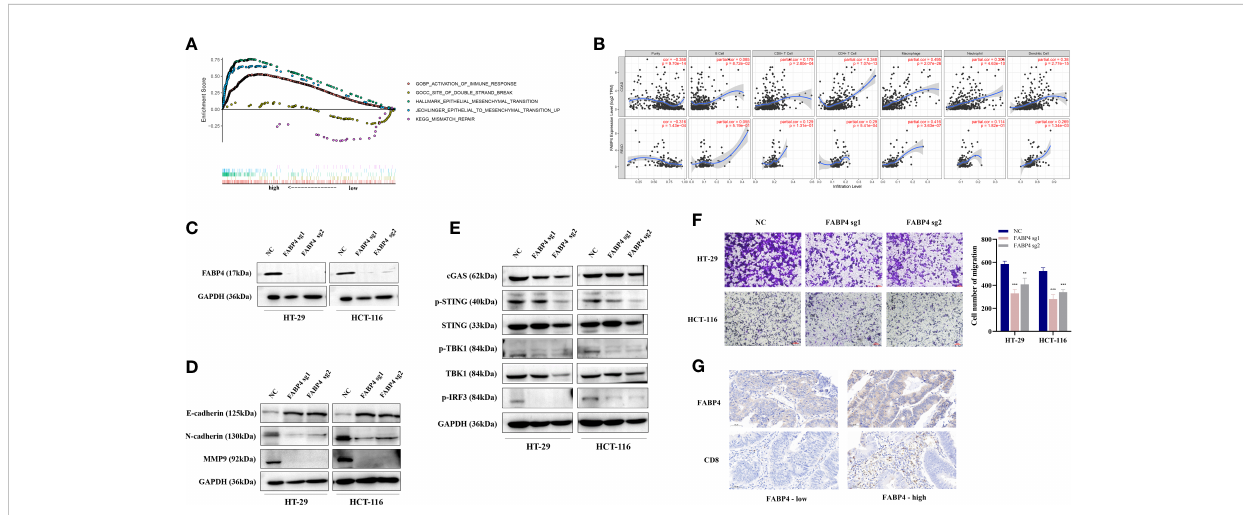
FIGURE 7 The biological function of FABP4 in CRC immunity and metastasis. (A) The TCGA-CRC dataset was divided into FABP4 high- and low-expression group based on FABP4 expression. GSEA analysis showed that the differentially expressed genes were signi fi cantly associated with immunity, EMT, and DNA damage repair pathways; (B) TIMER analysis showed a signi fi cant positive correlation between FABP4 and CD8 + T cells, CD4 + T cells, and neutrophils in CRC; (C) Western blot validated the knockout ef fi ciency of FABP4 in HT-29 and HCT-116 cells; (D) Western blot probed the expression of EMT-related proteins in FABP4 -KO cells; (E) Western blot showed the expression of DNA damage-repair-related pathway (cGAS-STING)-associated genes in FABP4 - KO cells; (F) transwell assay to explore the migratory ability of CRC cells after FABP4 knockout; (G) Immunohistochemical staining based on tissue microarrays from CRC patients to investigate the expression of FABP4 and CD8. **p < 0.01; ***p <